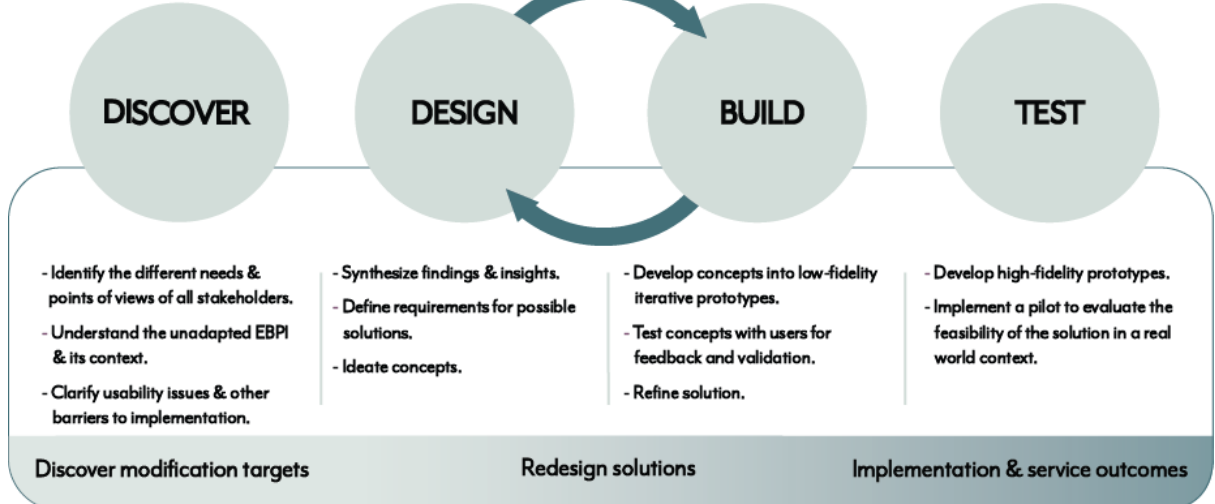
Figure 1. Discover, design/build, and test (DDBT) framework. EBPI: evidence-based psychosocial